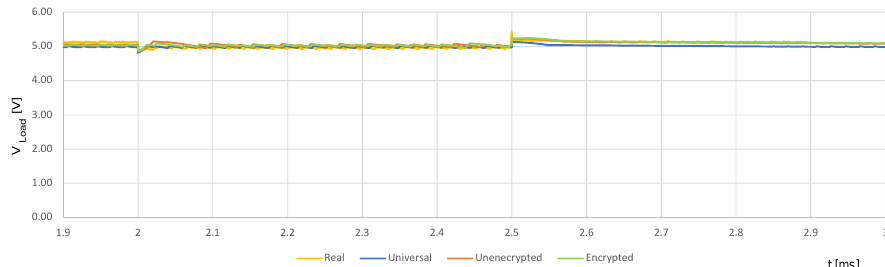
Figure 22. V Load models and real measurement time graph curves on dynamic load.